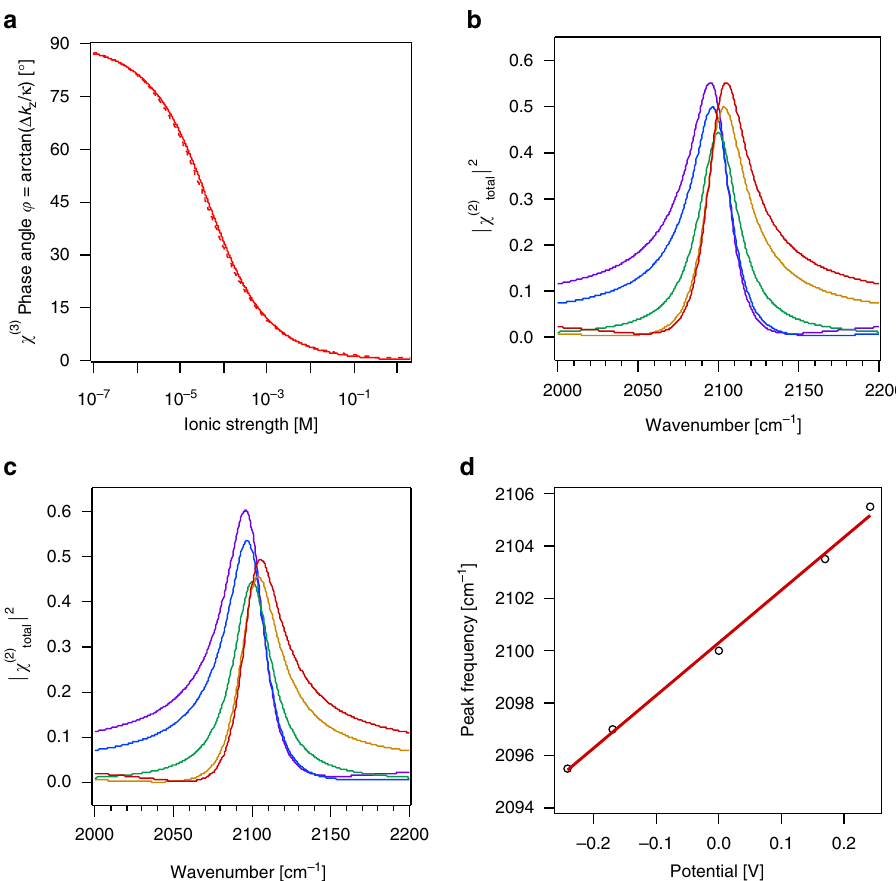
Fig. 1 Single oscillator. a The χ (3) phase angle φ computed for ω = 3000 cm − 1 (solid line) and 2100 cm − 1 (dashed line) from equation (4) as described in the main text for varying ionic strength. SFG intensity spectra of a single oscillator on a surface simulated for ω 1 = 2100 cm − 1 , A v M v = 10, Γ v = 15 cm − 1 , γ = 0°, χ (3) = 1.0, and Φ (0) = − 240 mV (purple), − 170 mV (blue), < 1 mV (green), + 170 mV (orange), and + 240 mV (red), with an ionic strength of 1 mM, 1 calculated without b and with c absorptive-dispersive interactions. d Peak frequency computed from equation (1) as a function of interfacial potential, Φ (0), and linear least squares fi t (red